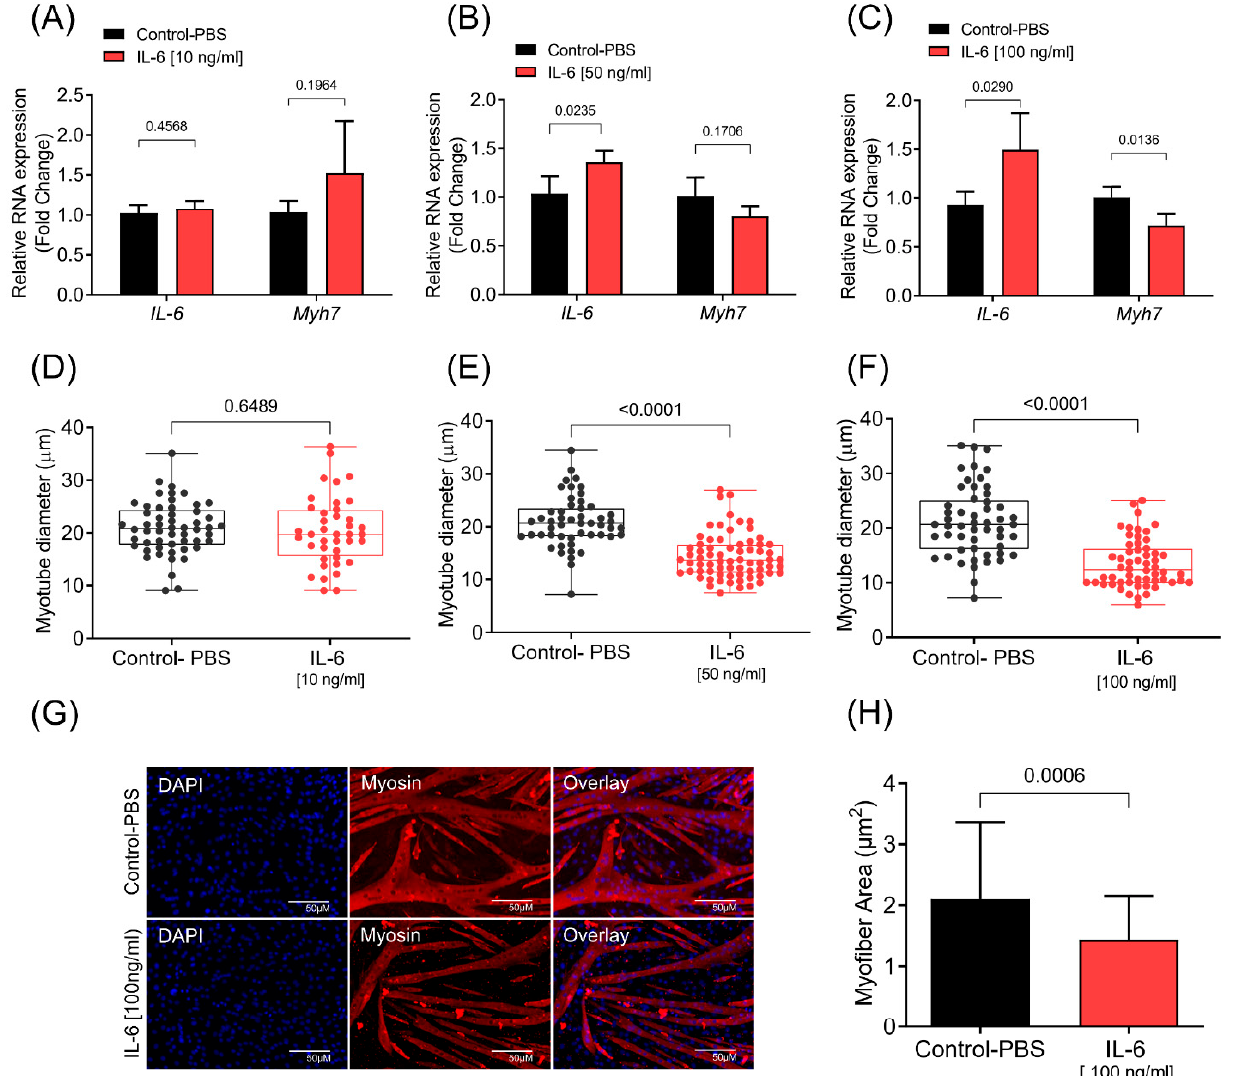
Figure 1. IL-6 induces C2C12 myotube atrophy. ( A – C ) IL-6 and Myh7 mRNA levels in differentiated C2C12 myotubes treated with three different concentrations of IL-6. RT-qPCR data are represented as fold change (2 ΔΔ Ct ) relative to Rpl13a . Data represent the average of three independent experiments with standard deviation. ( D – F ) Diameter of myotubes treated with IL-6 ( D , 10 ng/mL; E , 50 ng/mL; F , 100 ng/mL) myotubes with their corresponding controls. ( G ), Repre- sentative images of myotubes from both control and IL-6 treated (100 ng/mL) myotubes. Immunofluorescence was per- formed using the antibody against Myh2 and Dapi (4’,6-Diamidine-2’-phenylindole dihydrochloride). ( H ) Quantitative analysis of the myotube area of control and IL-6 treated myotubes (100 ng/mL) myotubes. ( I ) mRNA levels of embryonic myosin (Myh-emb) and ( J ) mRNA levels of atrogenes MAFbx and MuRF1 in differentiated C2C12 myotubes treated with